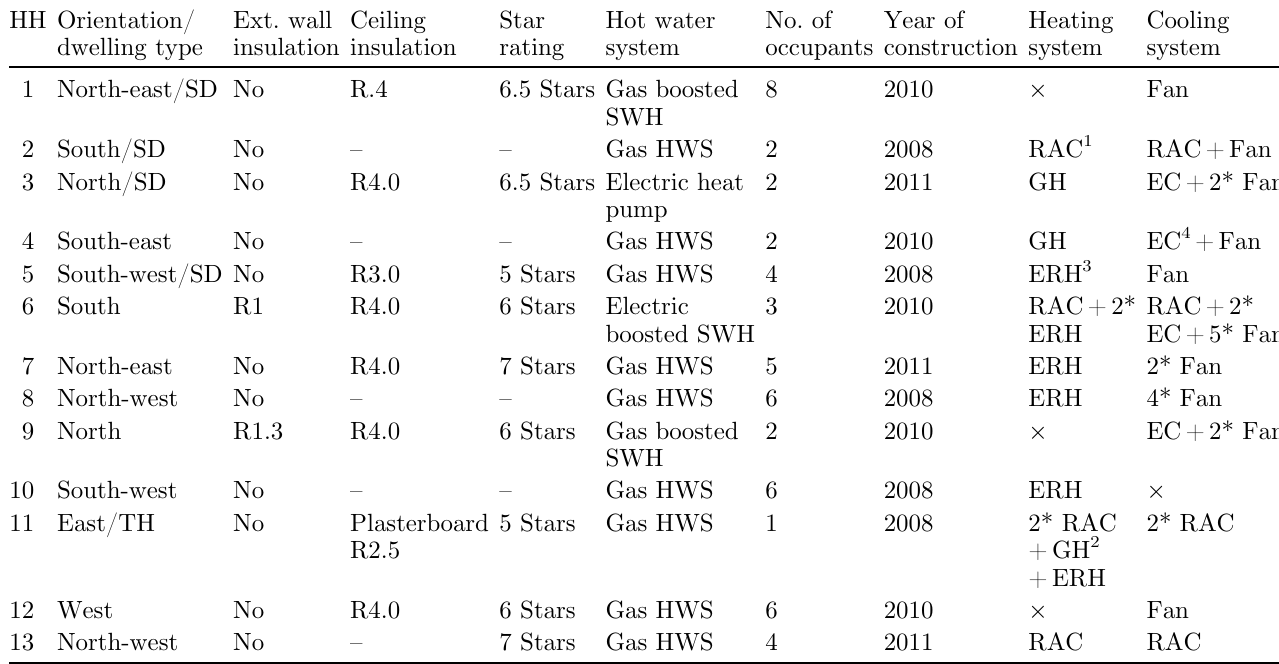
Table 1. Summary of building and occupancy related factors in the dwellings participated in energy